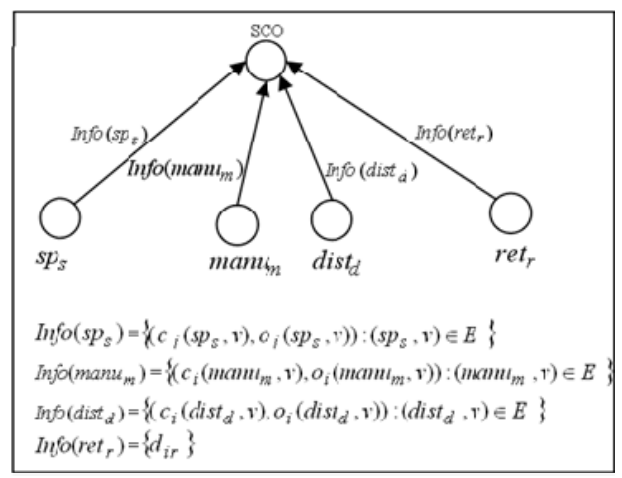
Figure 3: Information gathering phase